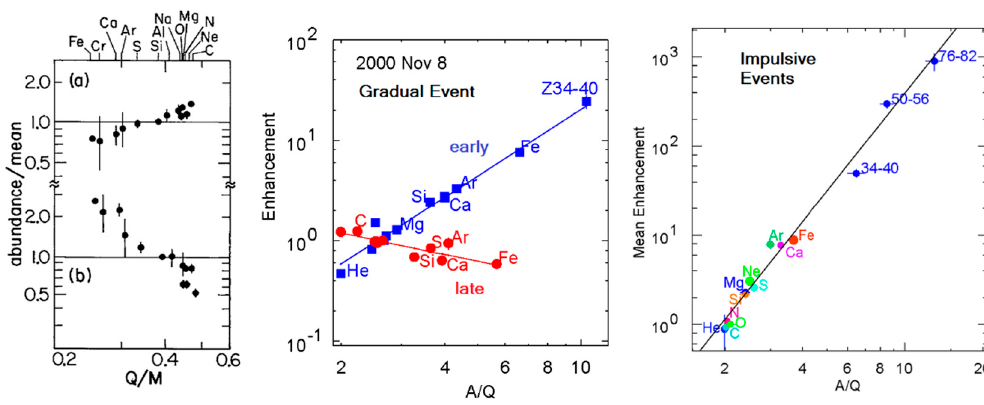
Figure 3. Abundance enhancements, relative to coronal abundances, are shown vs. Q/A for two gradual events by Breneman and Stone [64] ( left panel ). Variation within an event of enhancement vs. A/Q is shown during a gradual event [28] ( center panel ). The average enhancement vs. A/Q is shown for impulsive events [44] ( right panel ). Numbers in panels indicate a range of Z . Power-law enhancements vs. A/Q are quite common in SEP events.